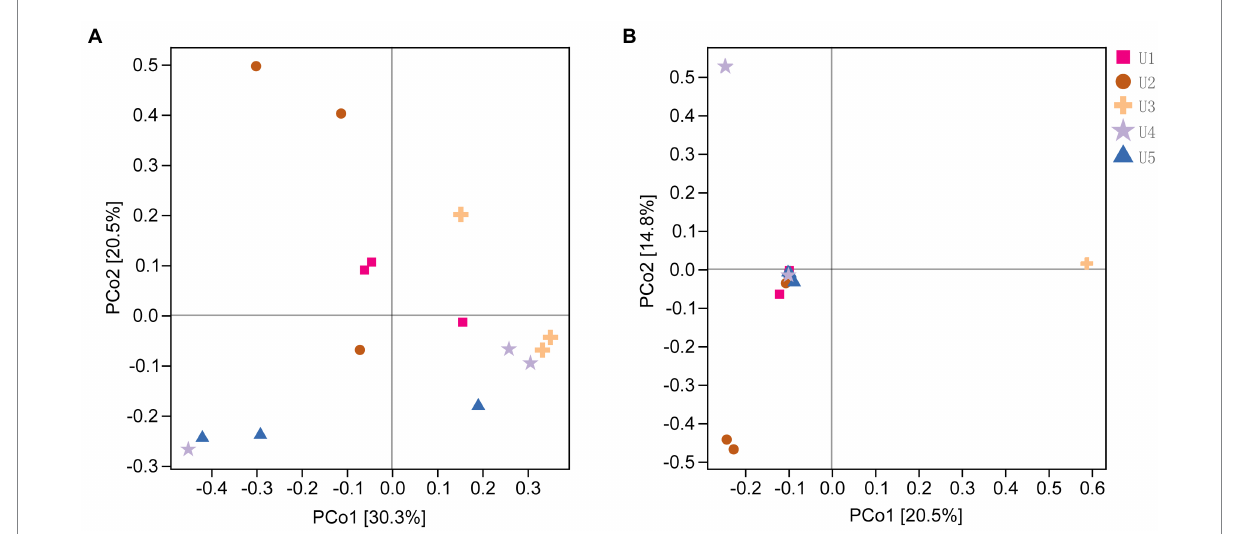
FIGURE 2 The Principal Coordinate Analysis (PCoA) of endophytic microbial communities associated with Usnea longissima at different altitudes by Bray- Curtis distance matrix. The distribution of the endophytic bacterial (A) and fungi (B) communities associated with U. longissima was shown. Each sample has three biological replicates. The value of the axis represents the percentage of variance that can be explained by each